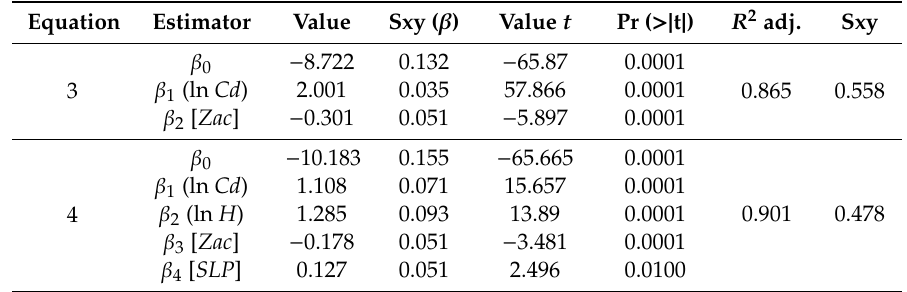
Table 2. Model statistics for predicting aboveground biomass of Agave lechuguilla Torr. in M é xico. Equation Estimator